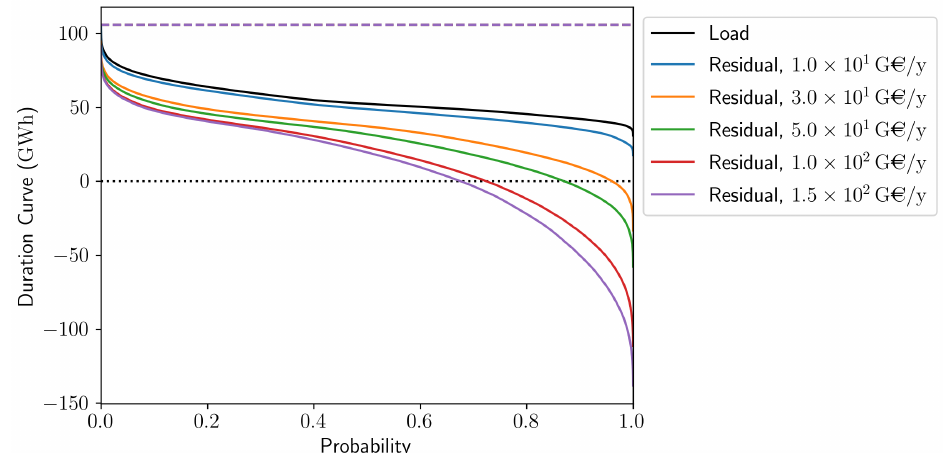
Figure 5. ( a ) Variable version of the expected system total cost (Equation (3)) for optimal solutions to the variable problem (blue), the constant problem (orange), and the decoupled problem (green). ( b ) Variable version of the average system marginal cost (Equation (9)) for optimal solutions to the variable problem (blue), the constant problem (orange), and the decoupled problem (green).